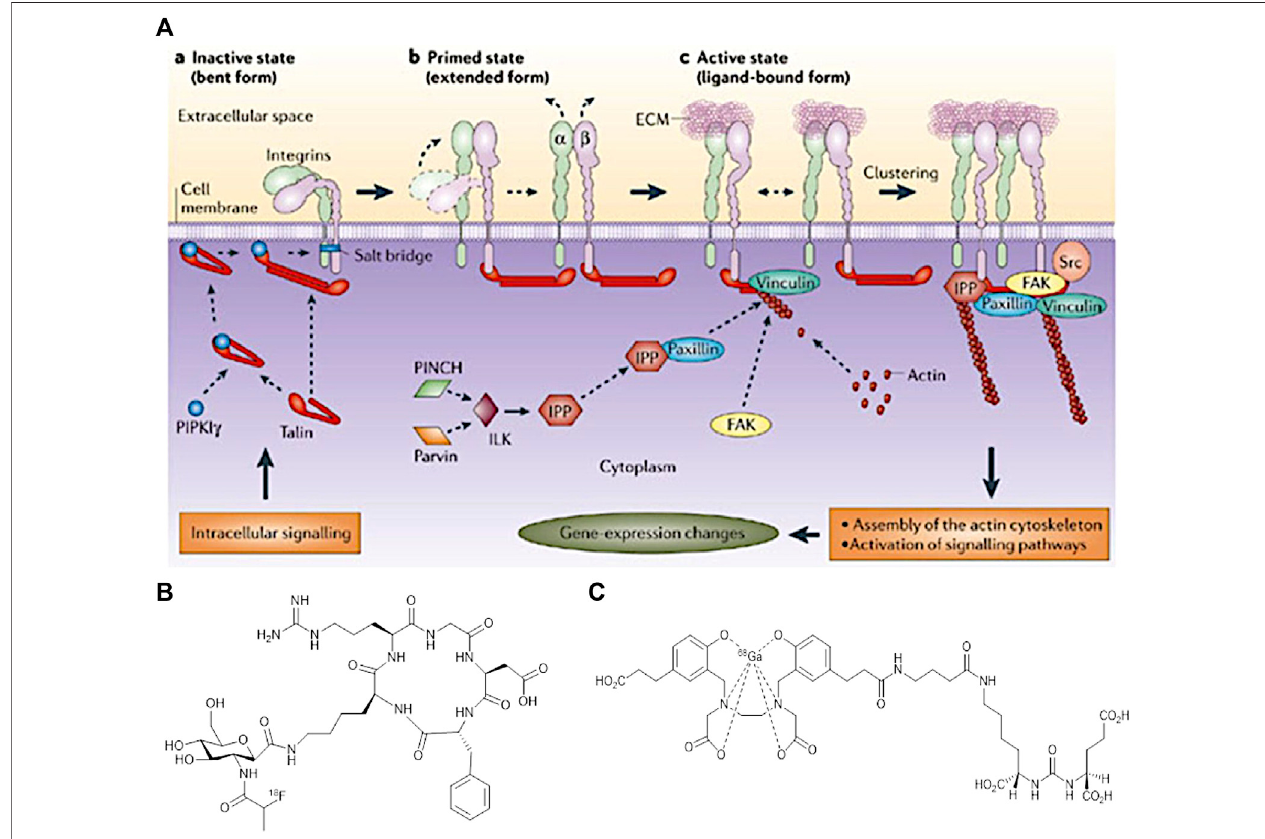
FIGURE7|(A) Interactionofintegrinswithextracellularandintracellularmolecules(BackerandBacker,2012) (B) Structureof[ 18 F]Fgalacto-RGDPETRadiotracer, and (C) The structure of [ 68 Ga]GaPSMA-11. (Figure adapted from reference (Rudin, 2005)).